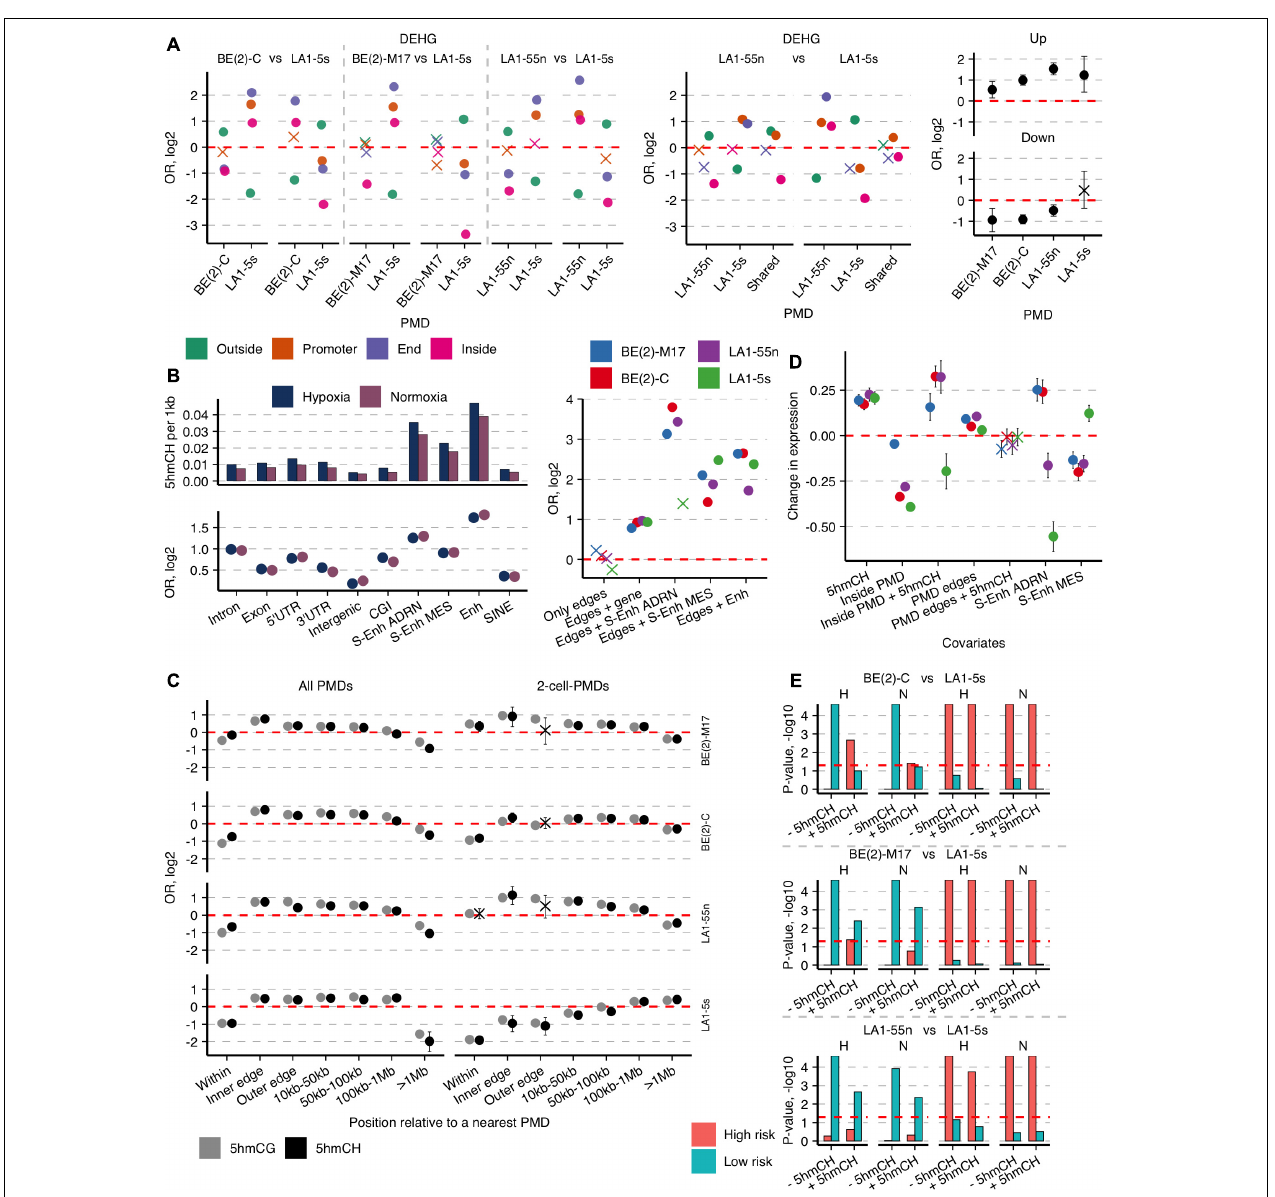
FIGURE 5 | Hydroxymethylated CH and CG dinucleotides mark important enhancers and cell type-specific genes and concentrate around PMDs. (A) OR from Fisher’s exact test for enrichment of the cell type-specific DEHGs across End, Promoter, and Inside groups of the unique 4-cell-PMDs (left) or 2-cell-PMDs (middle panel) and OR for enrichment of the hypoxia-affected Up- and Down-DEHGs (right) of each NB cell line across their own PMDs. (B) Left, numbers of 5hmCHs (per 1 kb) and OR from Fisher’s exact test for enrichment of 5hmCH sites across various genomic features in NB cell lines. Non-significant estimates ( p ≥ 0.05) are marked with “X.” Right, OR for enrichment of 5hmCH sites at PMD boundaries or PMD boundaries that overlap specific genomic elements—typical Enhs, ADRN and MES S-Enhs, and protein-coding genes. (C) Distribution of enrichment OR values of 5hmCHs and 5hmCGs at all PMDs or the 2-cell-PMDs and their boundaries. Inner and outer edges are represented by the 3-kb regions flanking both sides of PMD boundaries. (D) Weight coefficients representing the effect of 5hmCHs, PMDs, typical Enhs and ADRN and MES S-Enhs, and their combinations on gene expression. Coefficient estimates, standard errors, and significance were computed using a generalized linear model ( p -values ≥ 0.05 are marked with “X”). (E) Significance represented as permutation p -values (100 k permutations) of the overlap between the cell-type-specific DEHG groups split according to the 5hmCH enrichment status (- and +5hmCH) and the published DEHGs of NB tumors stratified according to patient survival and high-risk (HR) and low-risk (LR) tumors (Applebaum et al., 2019). “H” and “N” define hypoxia and normoxia, respectively. Significance threshold of p -values < 0.05 is presented with a horizontal